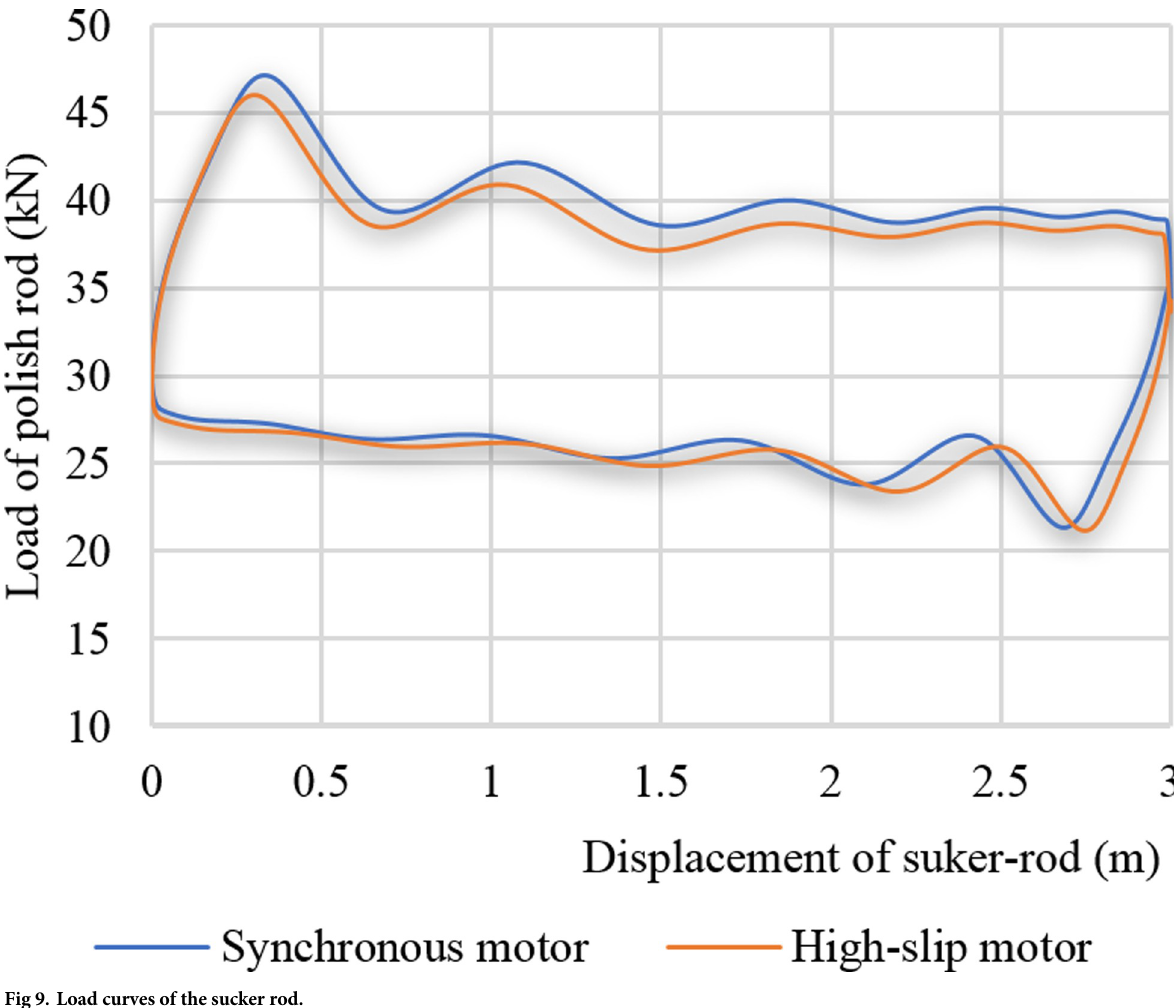
Fig 9. Load curves of the sucker